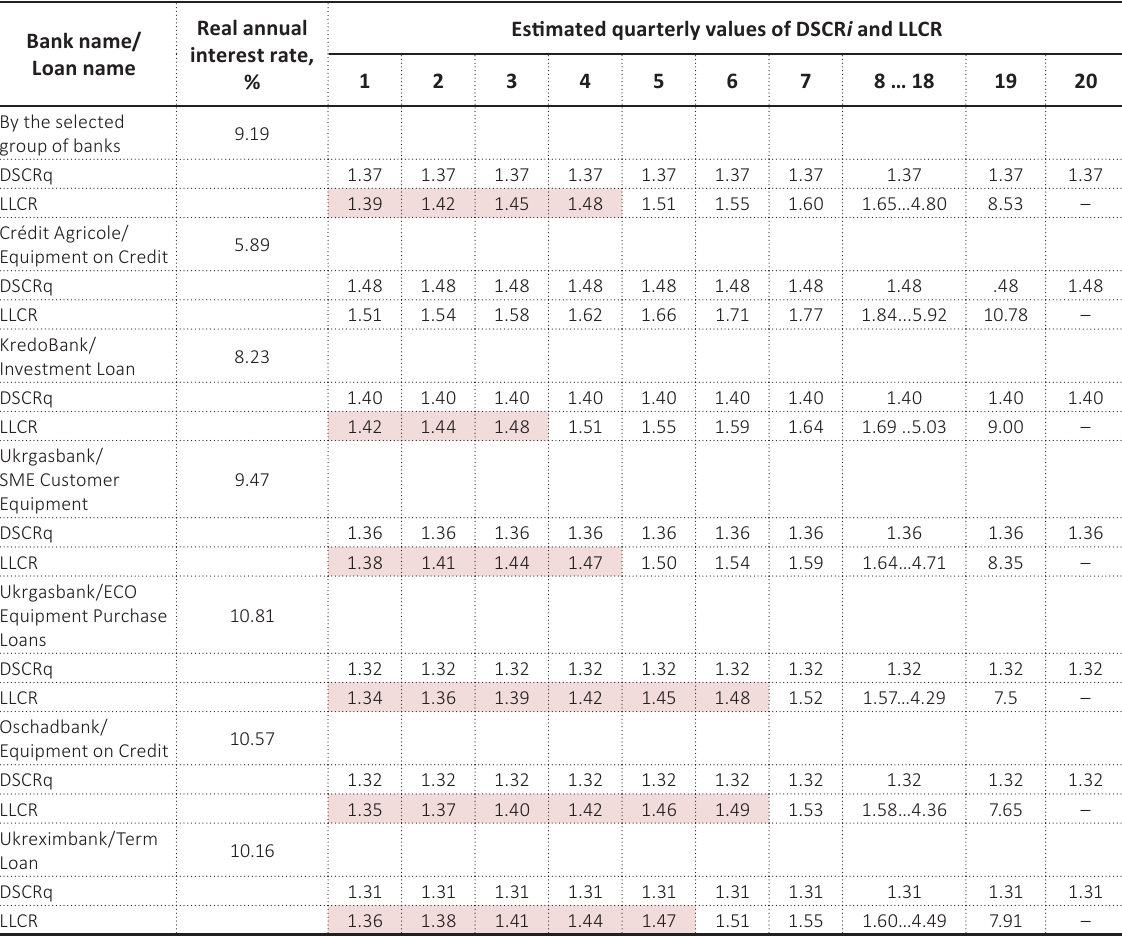
Source: Developed by the